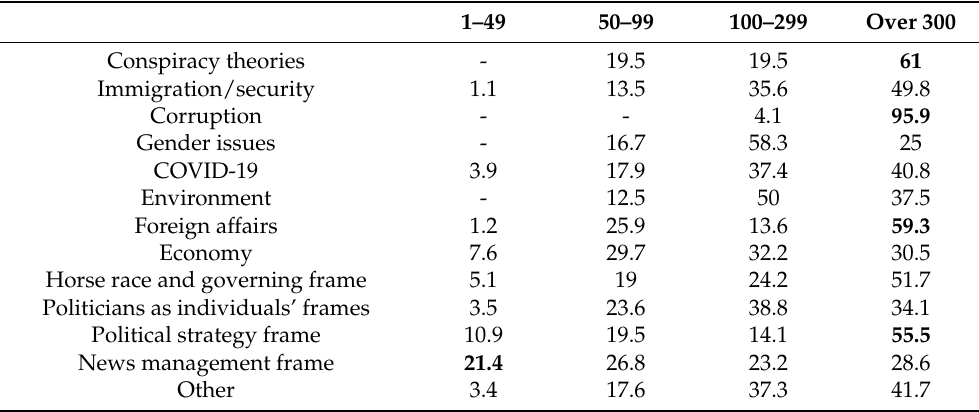
Table 3. Retweets by issue and game frames (%). Relevant findings are presented in